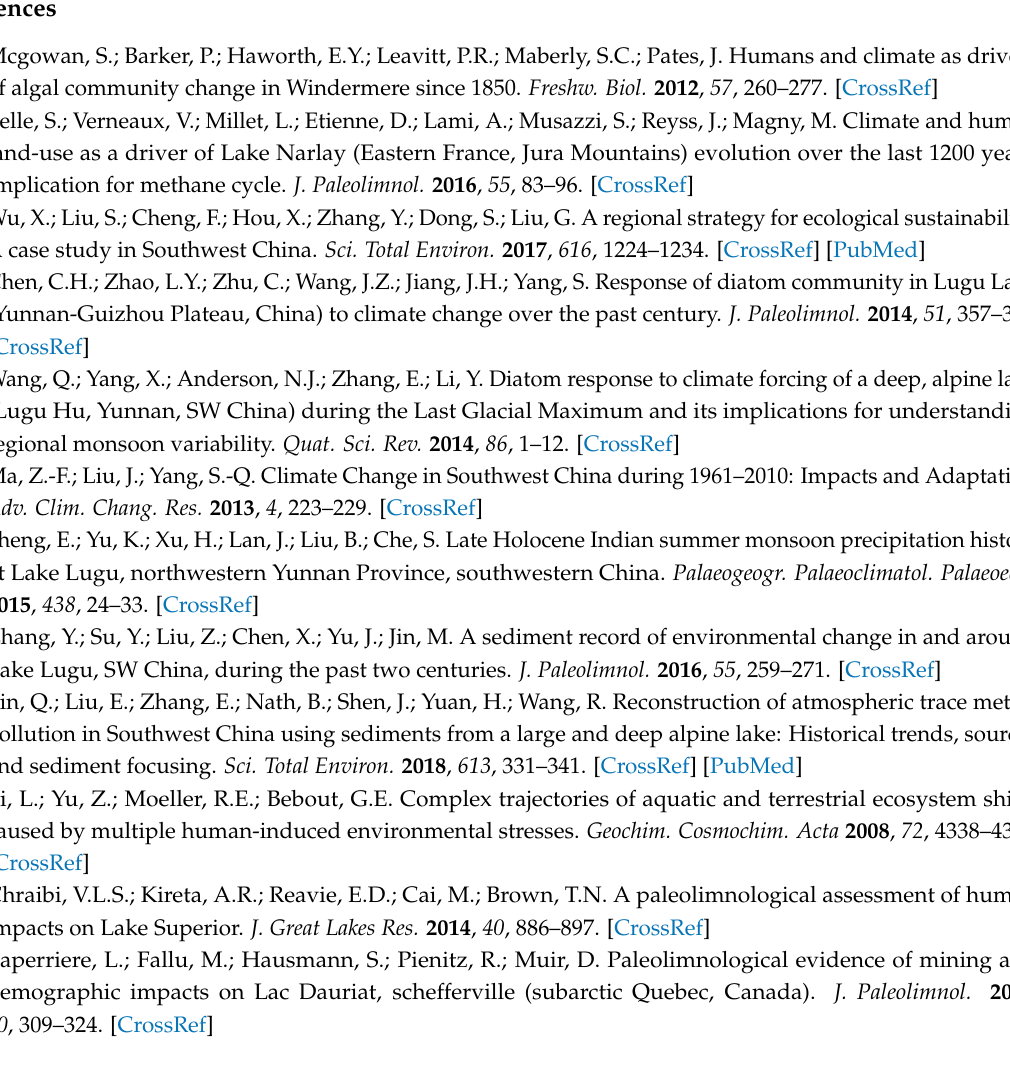
Figure A2. Sedimental diatom succession (Chen et al., 2014).